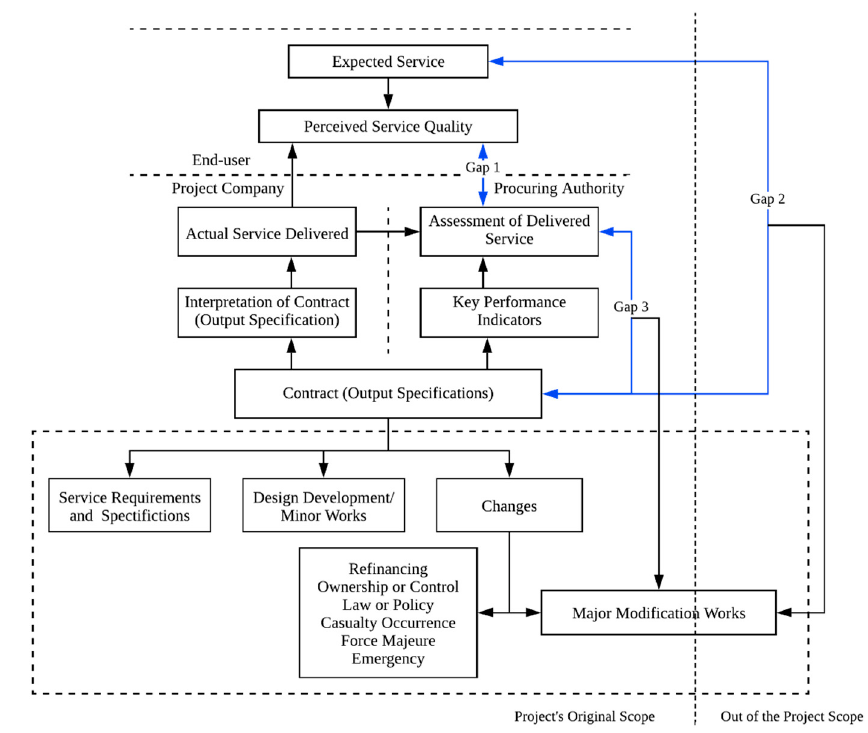
Figure 1. Service delivery process diagram within PPP practice. (Gap 1: di ff erence between the service quality perceived by end-user and the assessment of delivered service; Gap 2: di ff erence between end-user’s service expectation and output specifications in a contract; and Gap 3: di ff erence between the assessment of delivered service and contractual obligations in terms of output